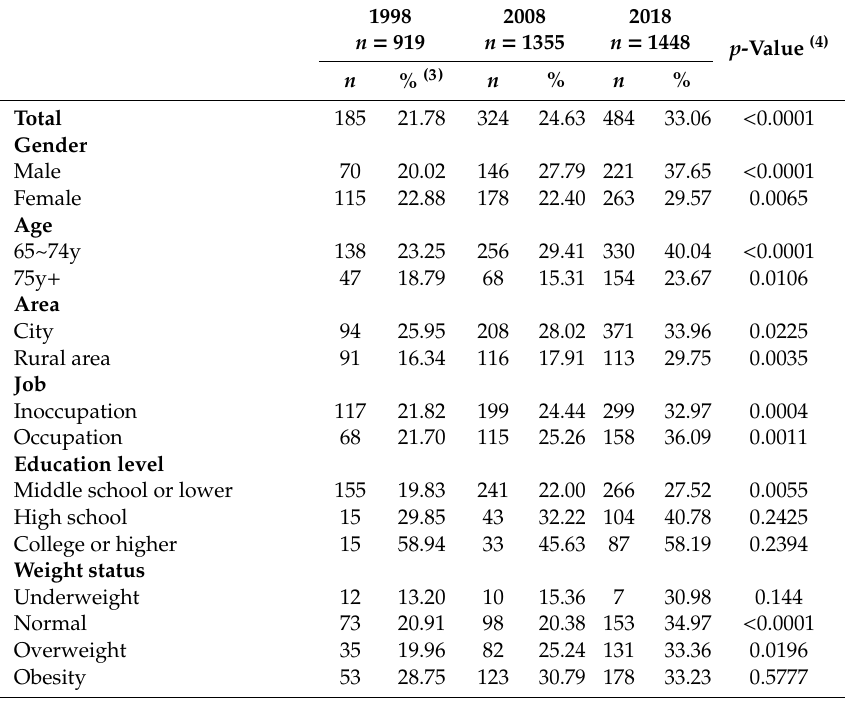
Table 6. Frequency and ratio of survey subject with intake level satisfying individual guideline of WHO and WCRF